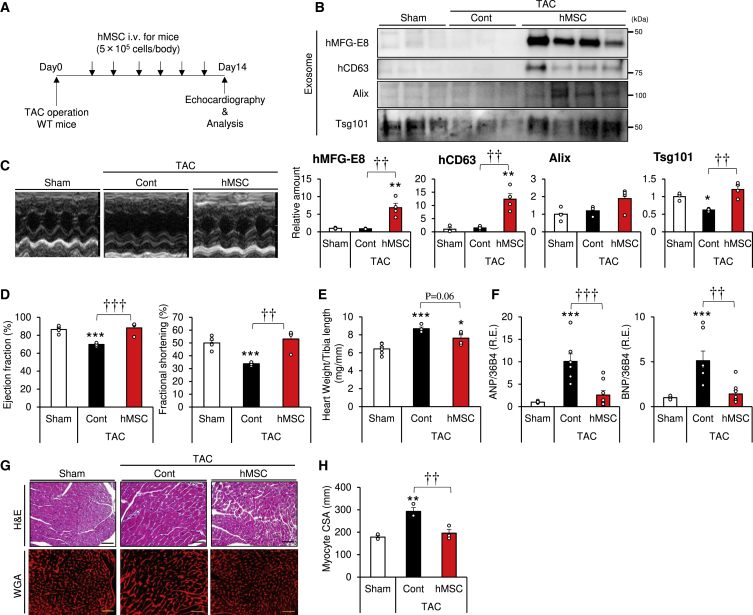
Intravenous Injection of hMSCs Improves Cardiac Function in Mice with Pressure-Overload-Induced Heart Failure(A) Experimental design for hMSC delivery into the transverse aortic constriction (TAC) model. hMSCs were injected at a concentration of 5.0 × 105 cells per body via the tail vein. The injection was repeated 6 times at 2- to 3-day intervals within a period of 2 weeks. Echocardiography was performed at day 14. (B) Serum exosomes were subjected to western blot analysis with the indicated antibodies of exosome markers (n = 3–4). (C–H) Comparison of heart tissue of WT mice with or without injection of hMSCs at 2 weeks after TAC or sham surgery. (C) Representative images of echocardiography. (D) Ejection fraction (EF) and fractional shortening (FS) measured at 2 weeks after TAC or sham surgery (n = 4–6). (E) Heart weight per tibia length ratio (n = 4–6). (F) Relative expression of heart failure markers of the indicated mice (n = 7–8). (G) Representative images of hematoxylin and eosin (H&E)-stained and wheat germ agglutinin (WGA)-stained sections of the apical heart (scale bars, 50 mm). (H) Myocyte cross-sectional area (CSA) calculated by BZ-X analyzer software (n = 3). Data are mean ± SEM. All experiments in this figure were tested in two separate trials. ∗p < 0.05; ∗∗p < 0.01; ∗∗∗p < 0.001 versus sham. ††p < 0.01; †††p < 0.001 between groups, by one-way analysis of variance with post hoc Tukey’s multiple comparisons.